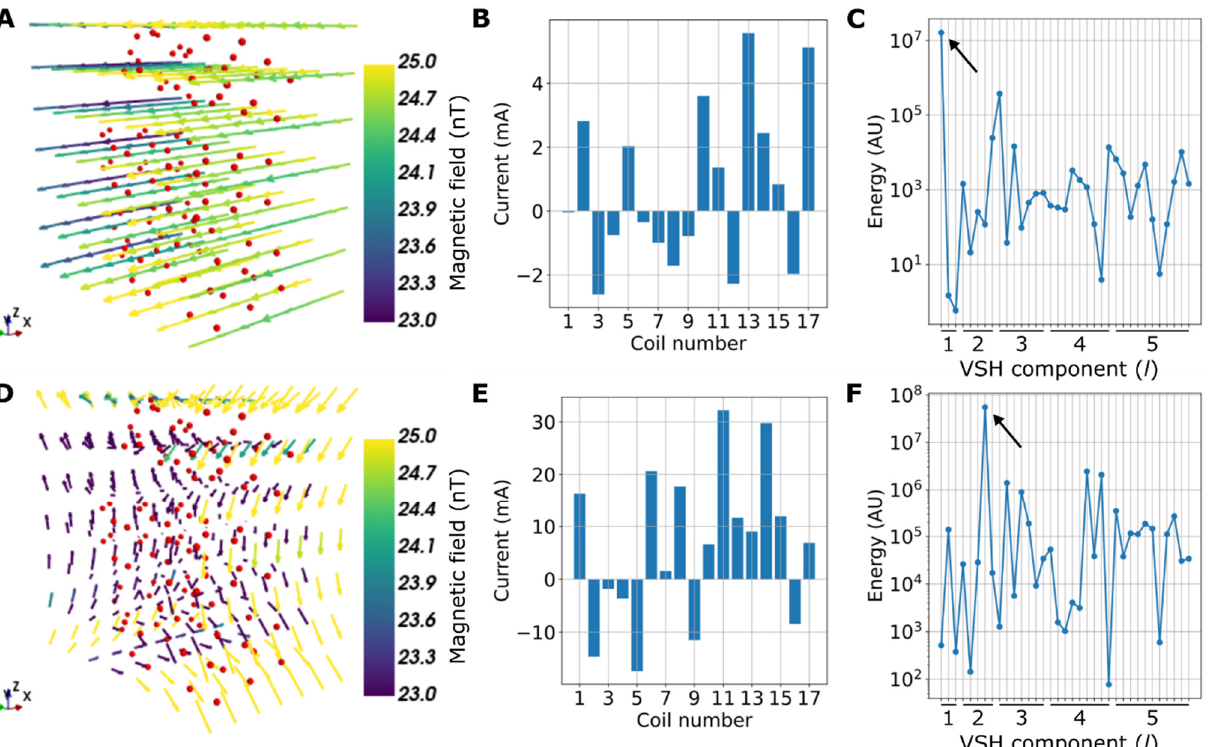
Figure 3. Examples of calculated coil currents of the 17 shield coils that generate specific vector spherical harmonic (VSH) field components: ( A ) Example of a homogeneous magnetic field in the vicinity of the measurement points, shown as red dots. ( B ) The coil currents that generate the field shown in ( A ). ( C ) The VSH spectra of the generated field; the black arrow indicates the energy of the desired VSH component. ( D – F ) Same as ( A – C ), but for a first-order gradient field.